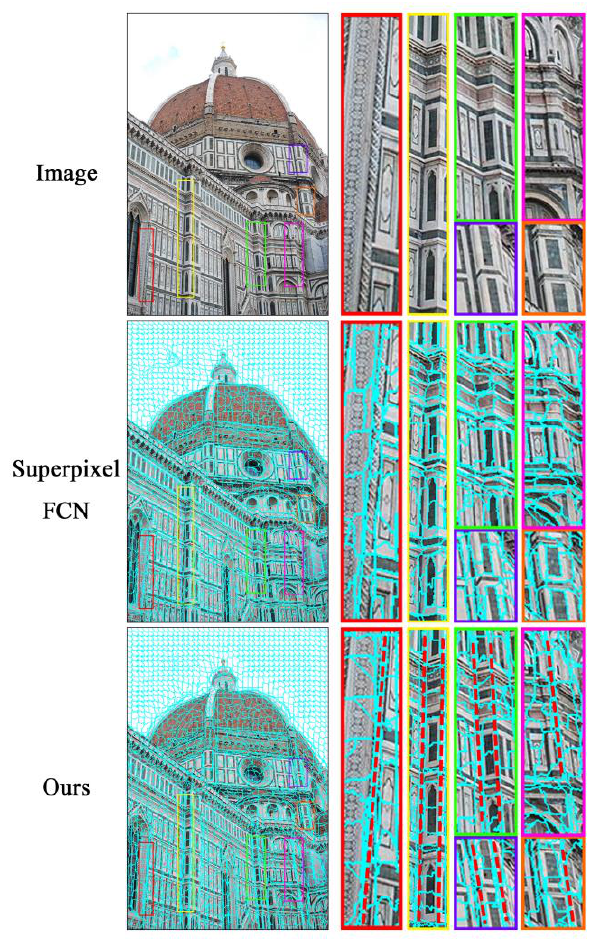
Figure 10 . Comparison of the results for superpixel segmentation method on building with flexible